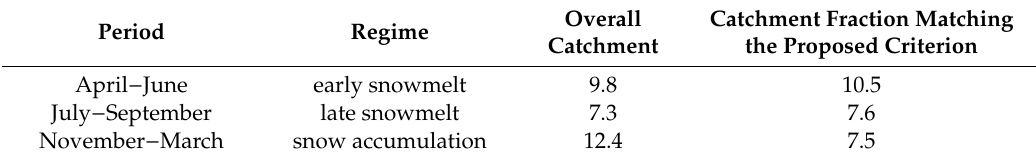
Table 4. Mean absolute error (% fSCA) between median fSCA simulated with TOPMELT and MODIS-based fSCA considering the whole catchment and only the fraction matching the proposed criterion (i.e., open sites and forest sites where the solar illumination level exceeds 17 MJ m 2 d − 1 ). Period